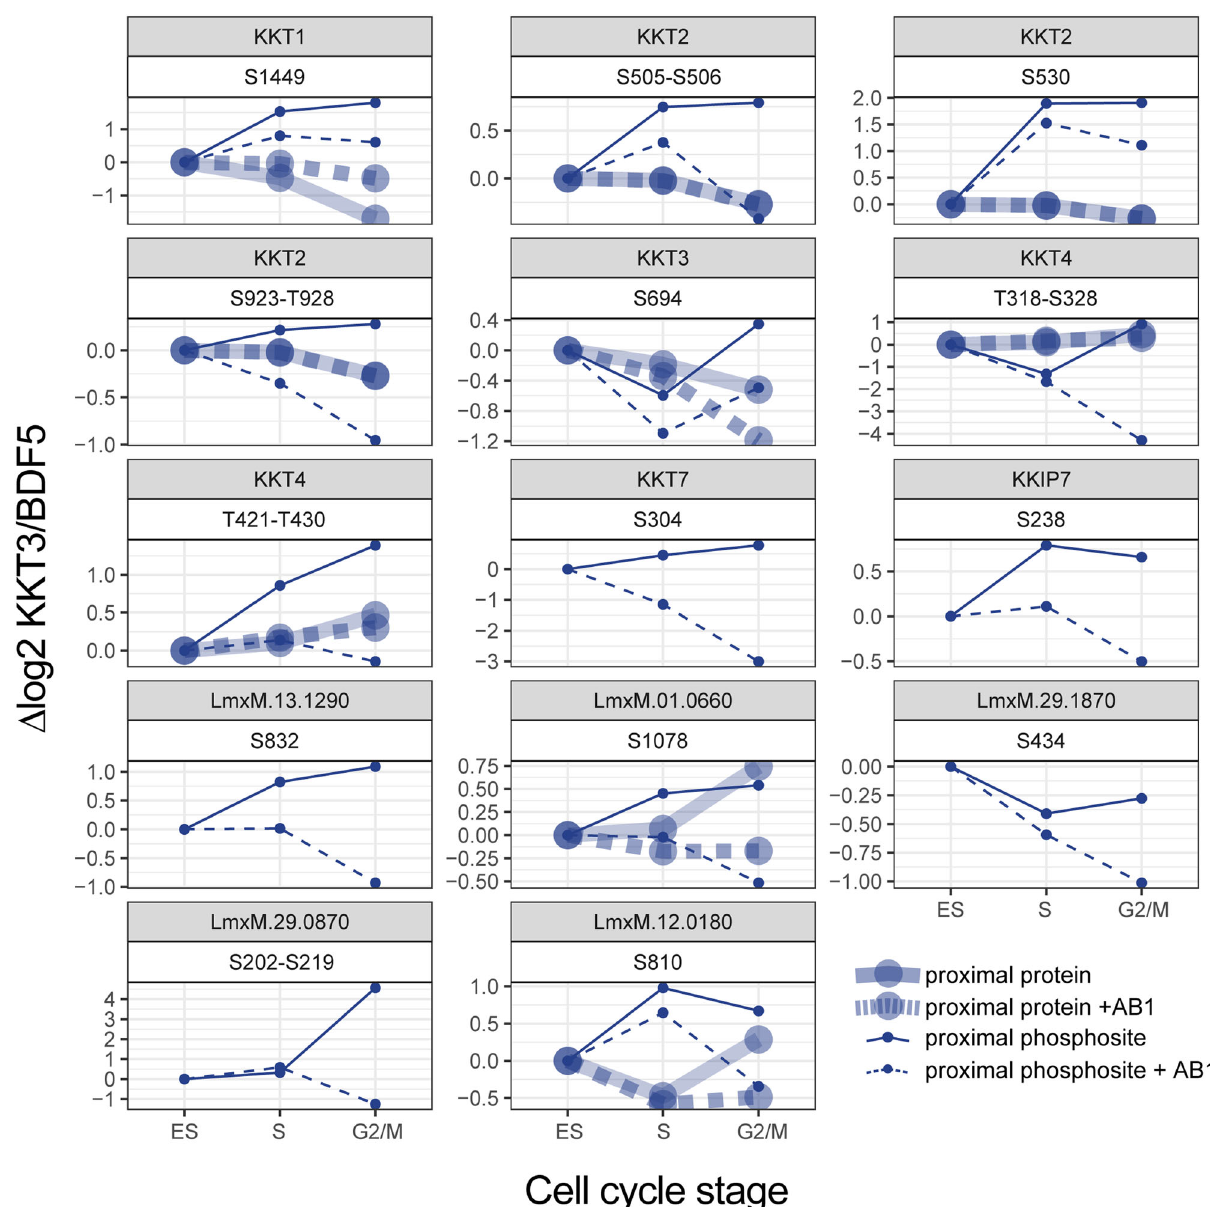
Fig. 6 Proximal pro fi le plots of AB1 responsive phosphosites and protein levels. At each timepoint, mean log2 fold enrichments against BDF5 spatial reference are normalised to the log2 fold enrichment at time 0, n = 5. Where a phosphosite could not be con fi dently localised, the possible phosphorylated region is